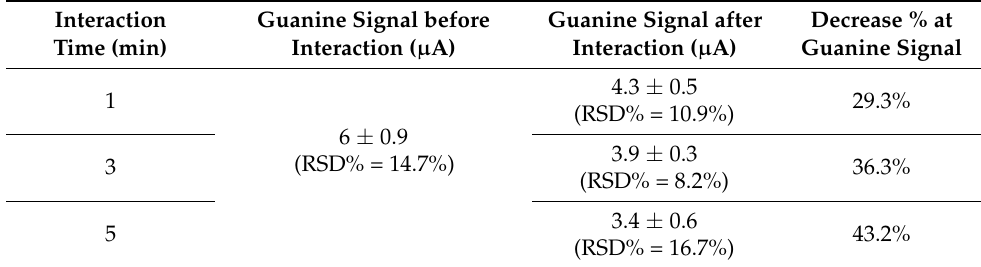
Table 1. The average guanine signals in case of different interaction times and the decrease% ratios after interaction of curcumin–ctDNA ( n =